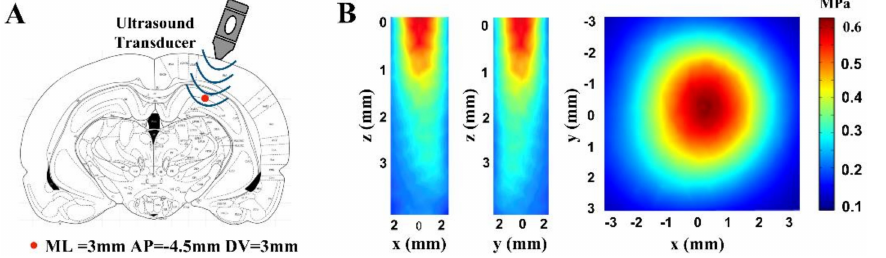
Figure 2. Ultrasound stimulation region and ultrasound distribution. ( A ) The region for ultra- sound stimulation (ML = 3 mm, AP = − 4.5 mm, DV = 3 mm relative to Bregma). ( B ) The two- dimensional sonication distribution in the xz, yz, and xy